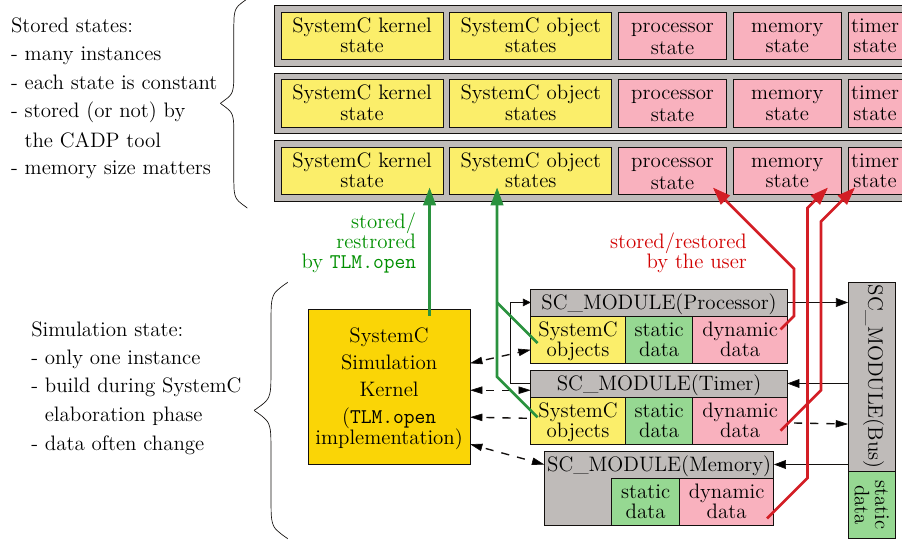
Figure 4 Memory layout: simulation state and stored